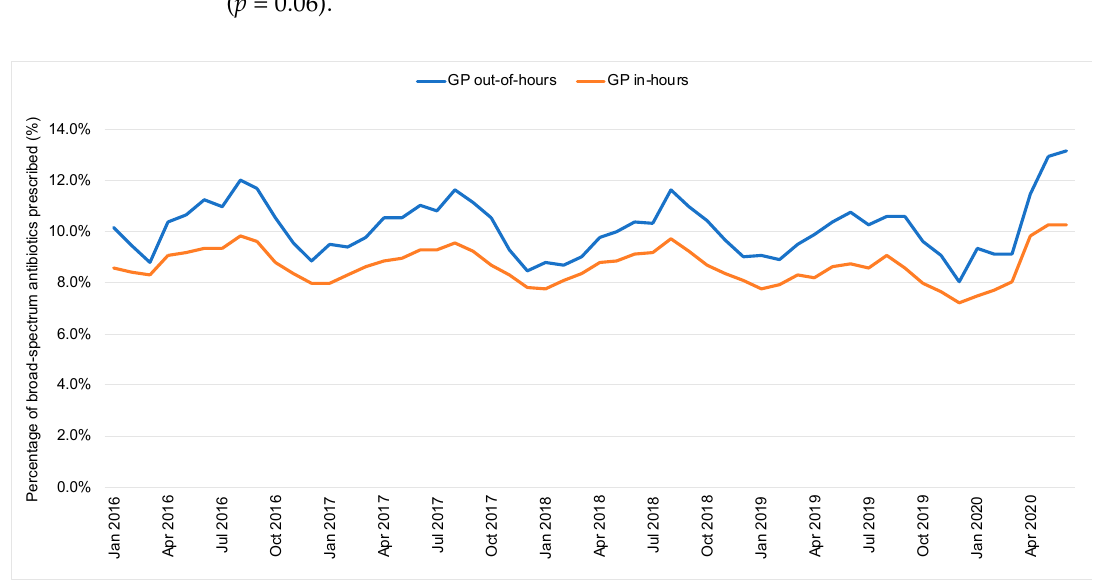
Figure 2. Percentage of broad-spectrum antibiotics prescribed (England, 2016–2020).